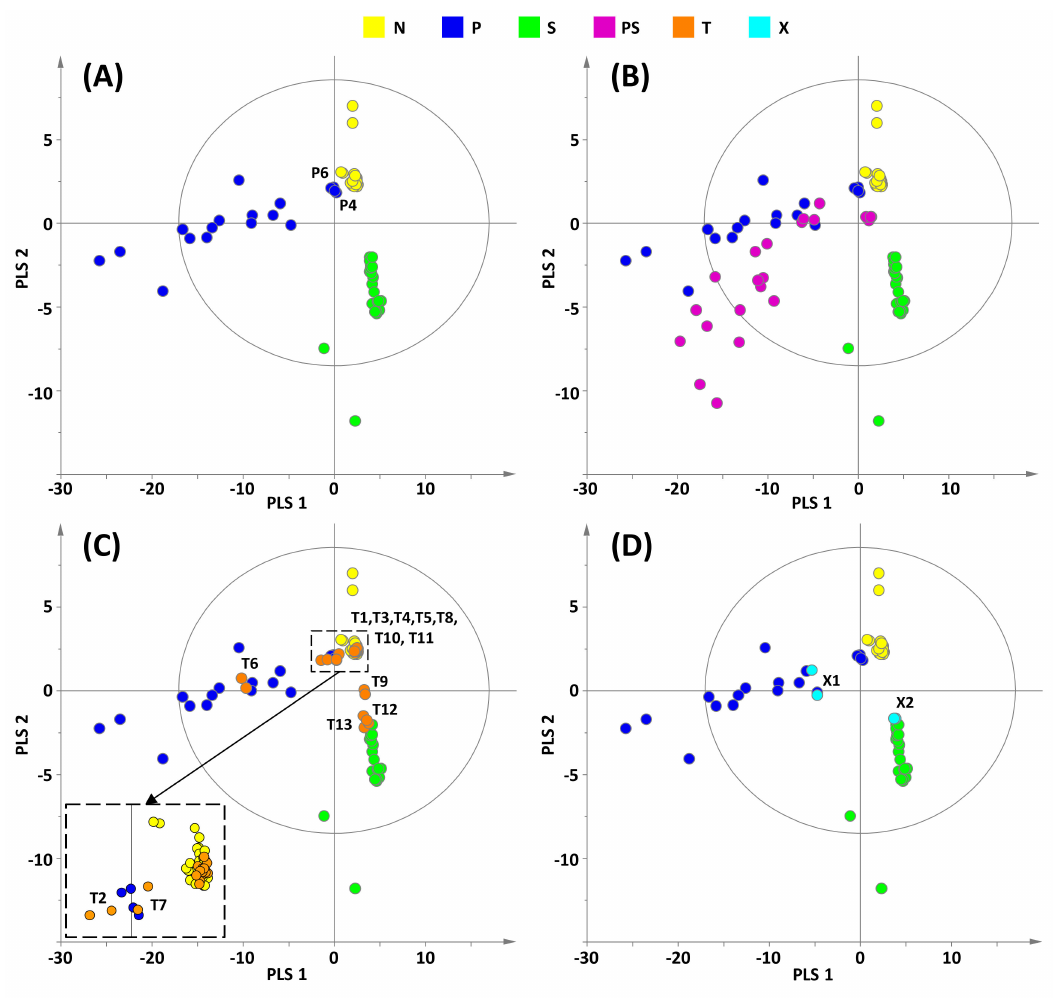
Figure 3. ( A ) Score plot of the PLS-DA three-class model built from LF 1 H NMR spectra of samples N (non-adulterated), S (adulterated with sibutramine), and P (adulterated with phenolphthalein). Score plots ( B ), ( C ) and ( D ) show the projection of samples PS (adulterated with both sibutramine and phenolphthalein), T (test samples) and X (atypical samples, see text) respectively on the built model